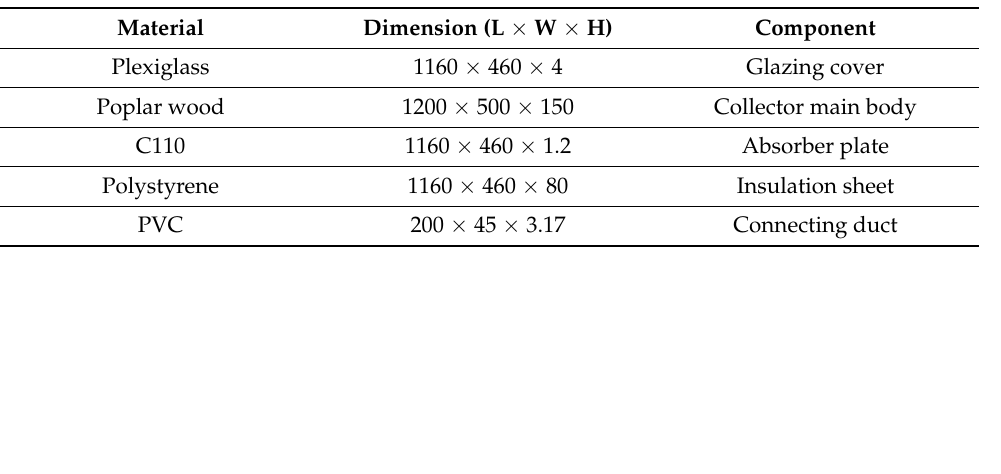
Figure 2. Schematic diagram of the drying unit with the draught system. Table 2. The geometrical detail of the solar